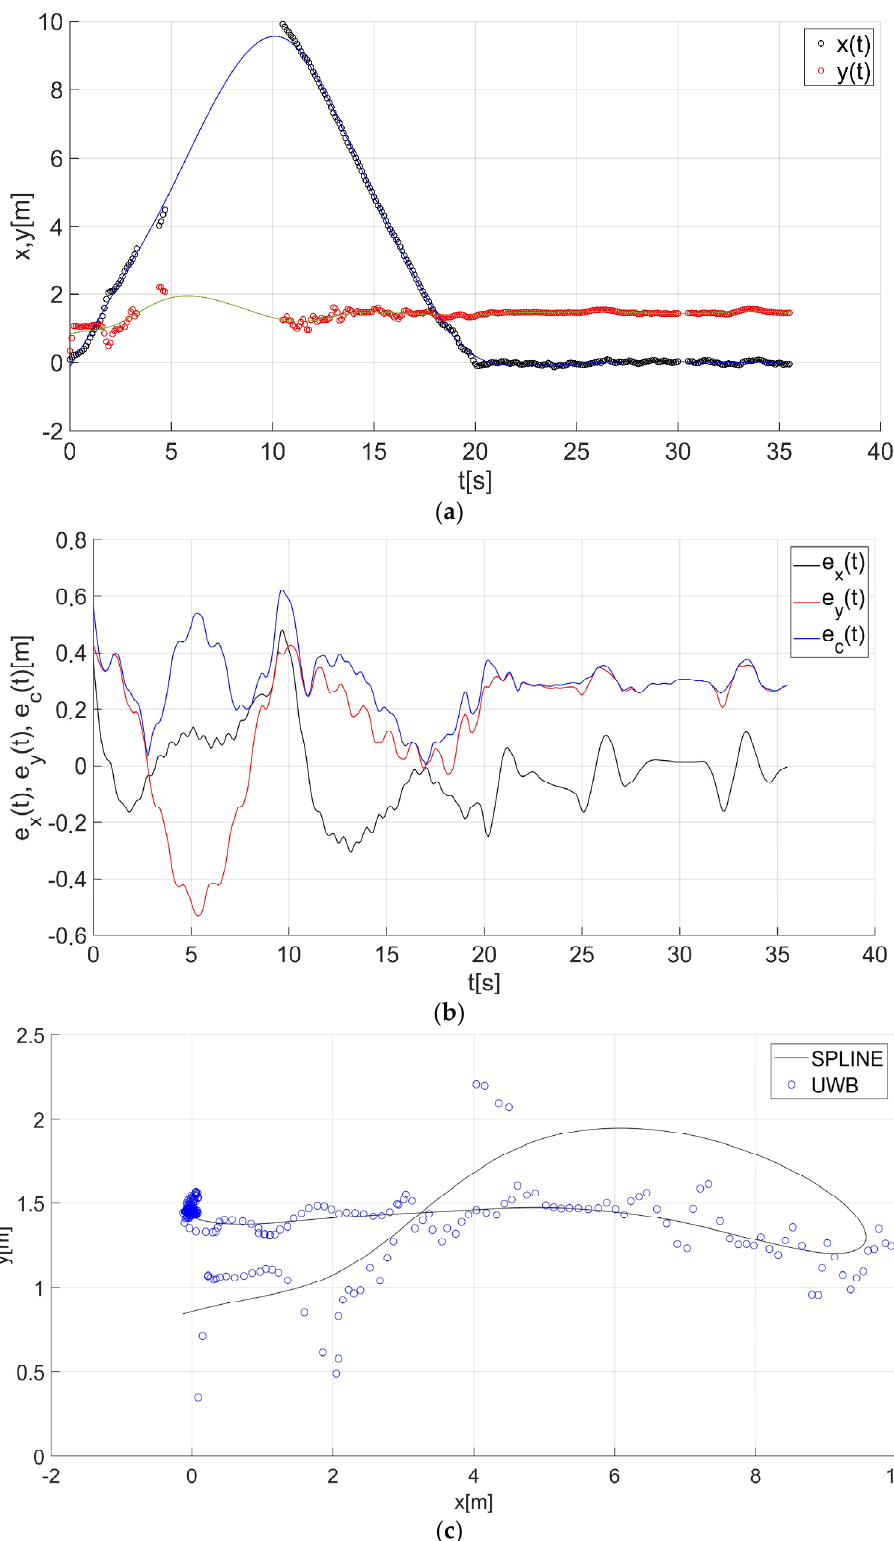
Figure 19. Results for the estimation of guide’s path no. 7 with the use of smoothing spline: ( a ) the course of the guide’s location coordinates x(t), y(t) with their continuous estimates, ( b ) the course of the estimated location errors e x (t), e y (t), e c (t), ( c ) guide’s location along with the path estimation [6]. The courses of the estimated coordinates of the guide’s position at x(t), y(t) are pre- sented as a function dependent of time in Figures 13a, 14a, 15a, 16a, 17a, 18a, and 19a,